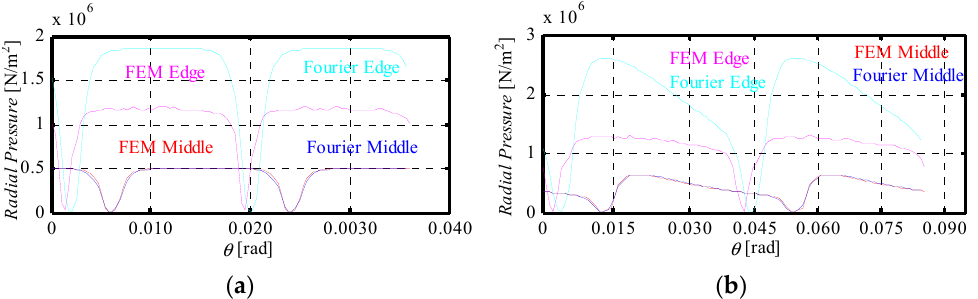
Figure 17. Magnetic pressures on the tooth base in the Qs36p15 machine: ( a ) in open-circuit condition, ( b ) in load condition. Figure 16. Magnetic pressures on the tooth base in the Qs48p8 machine: ( a ) in open-circuit condition, ( b ) in load condition.